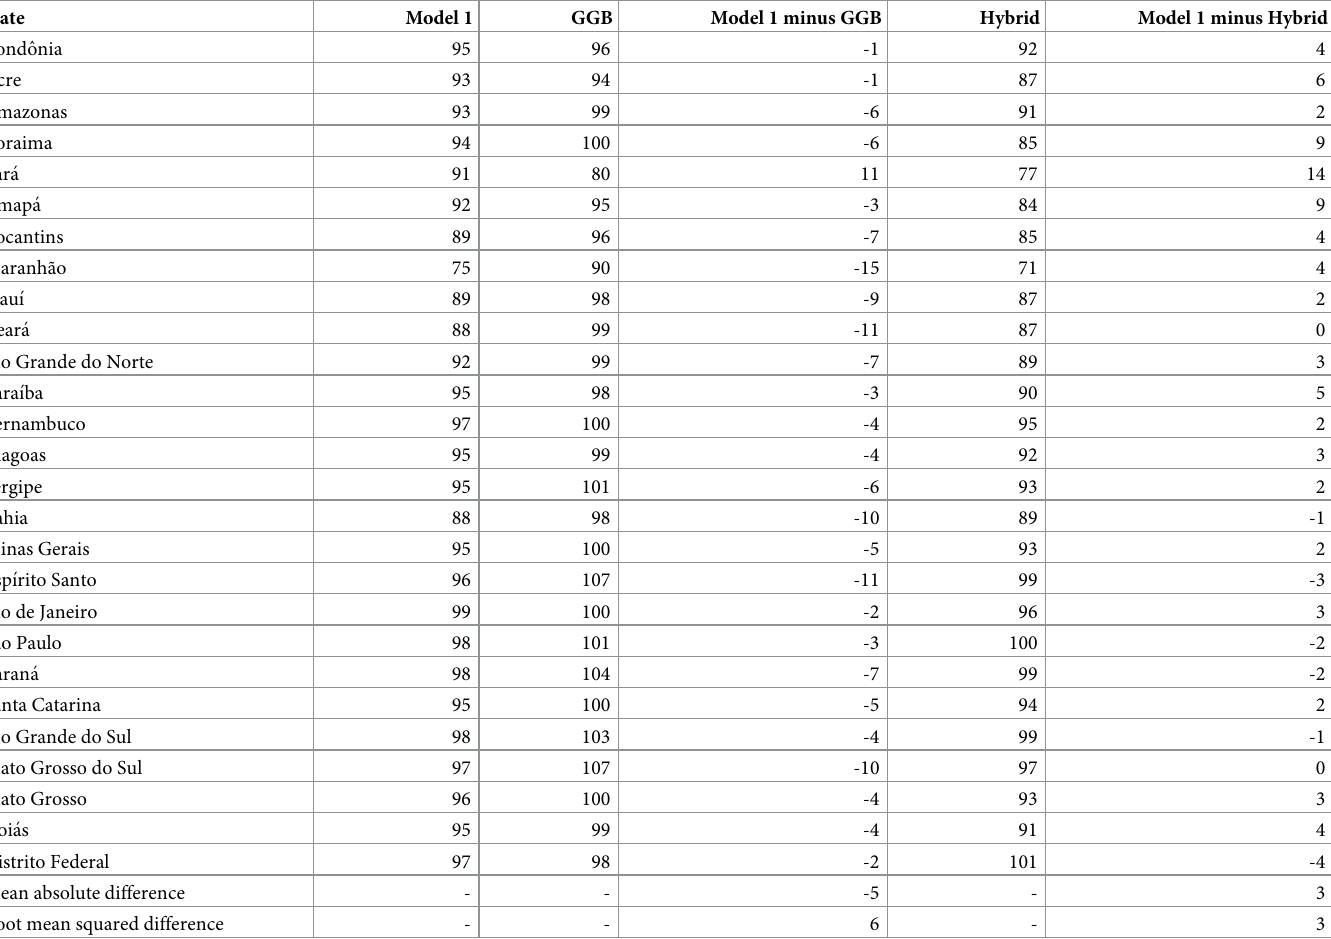
Table 7. Predicted completeness and Queiroz et al (2017) estimates of completeness by state of residence (%), Brazil, 2000–2010, both sexes, ages